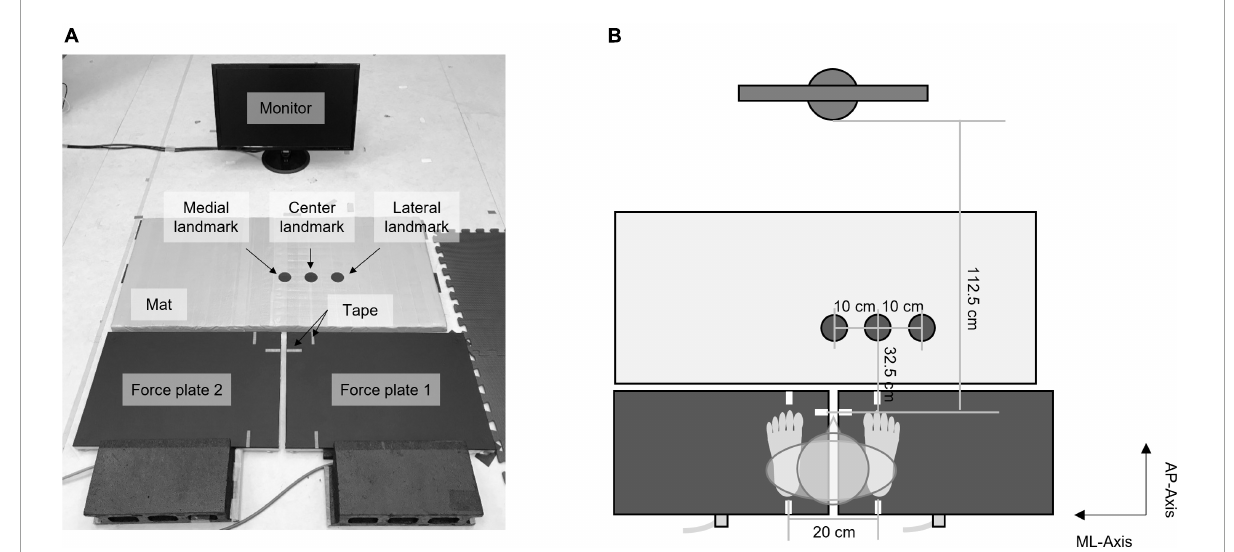
FIGURE2 Task setup: (A) a picture of the task setup; (B) top view of the configuration of the task